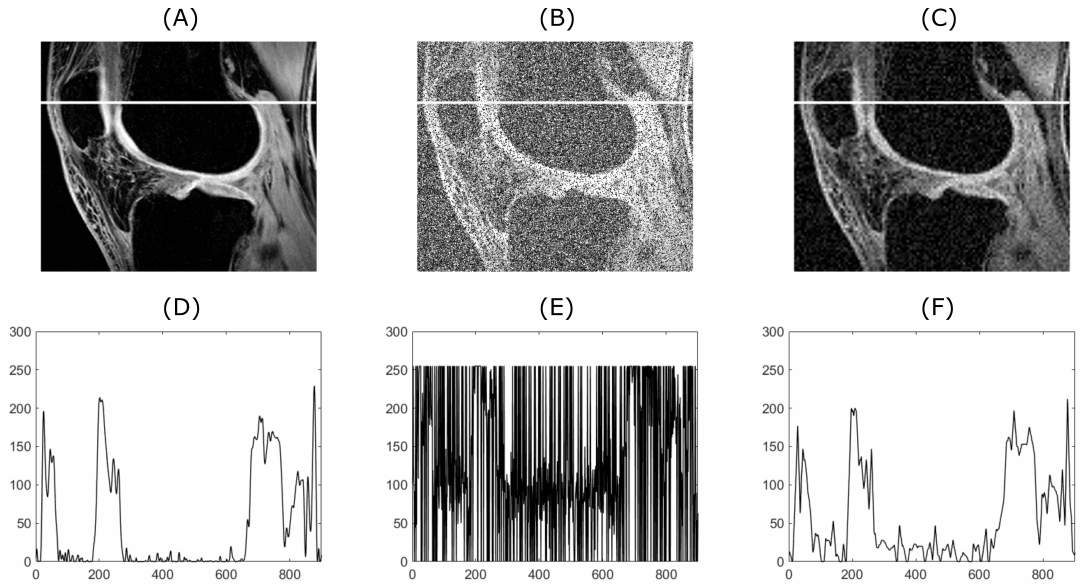
Figure 5. From ( A ) to ( C ), the upper row shows the original image, the image with added artificial noise and the image denoised by the described algorithm. As an input image, an MRI scan shown in Figures 1 and 2 was used. The lower row ( D – E ) shows plots corresponding to the white line drawn in the images depicted in the upper